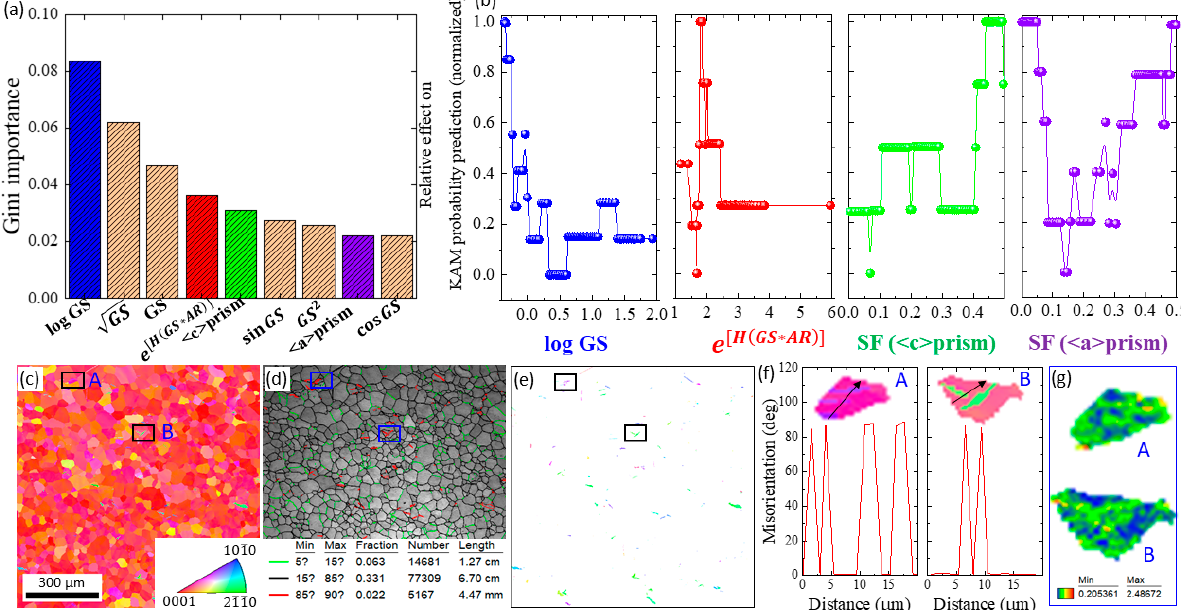
Figure 6. ( a ) The top 9 important features, as found by the ERT ML model built in the present work. ( b ) The relative probability related to 4 important features out of the top 9 in Figure 6a. ( c – e ) Inverse pole figure (IPF), image quality (IQ), and partitioned twin maps, respectively. The colorful lines in IQ map (Figure 6d) represent the boundaries, which are classified according to their misorientation, where a red line represent the twin boundaries with misorientation of ~86o. ( f ) The ( A , B ) twined grains, as partitioned from the full microstructure presented in Figure 6c,d, and the point-to-point misorientation profiles taken along the inserted arrows. The profiles in ( f ) shows the evolution of the tension twins. ( g ) The kernel average misorientation of the two partitioned grains ( A , B ). The unit of GS is micrometer, and AR and SFs are dimensionless.